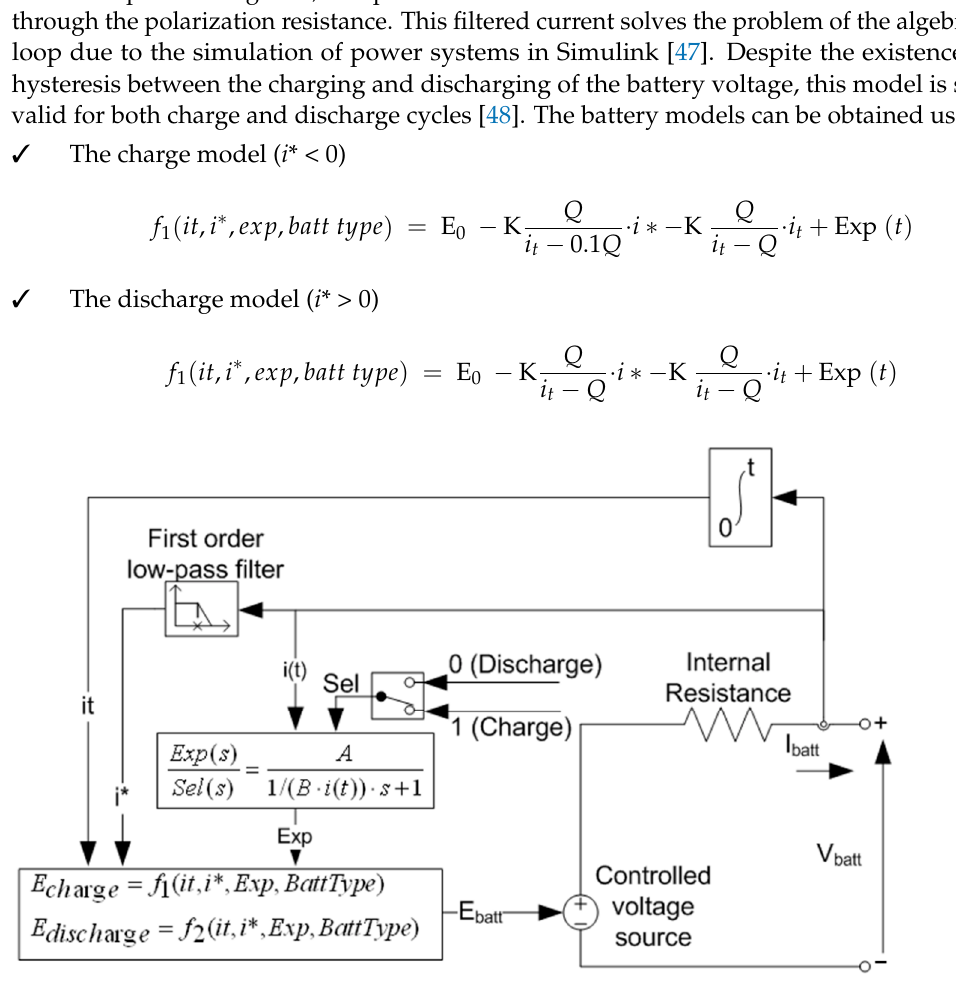
Figure 3. Graphical description of the employed battery model.